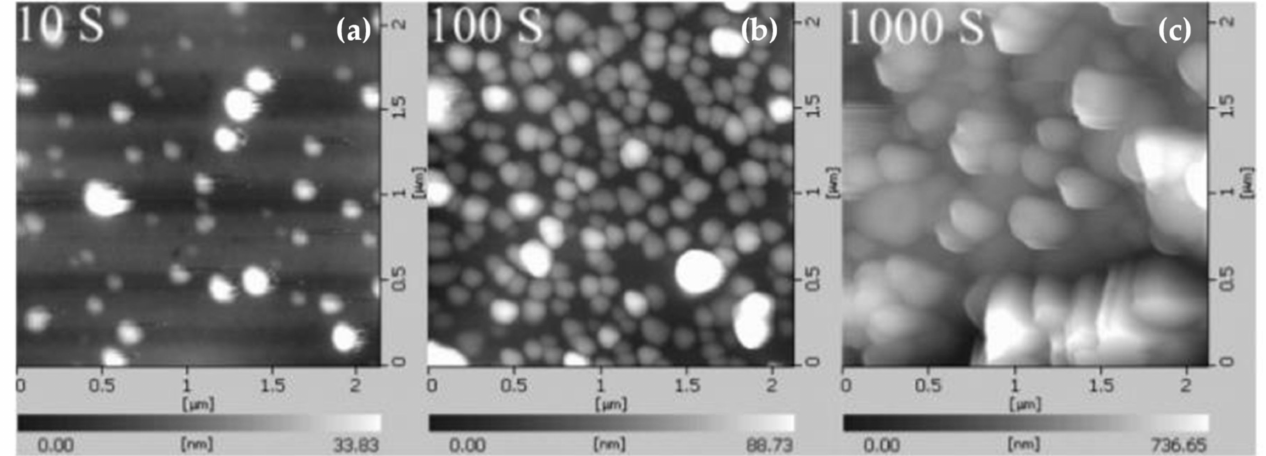
Figure 19. Silver nanostructures formed by electrostatic potential deposition at different times. Reprinted with permission from Ref. [178]. Copyright 2007 American Chemical Society.